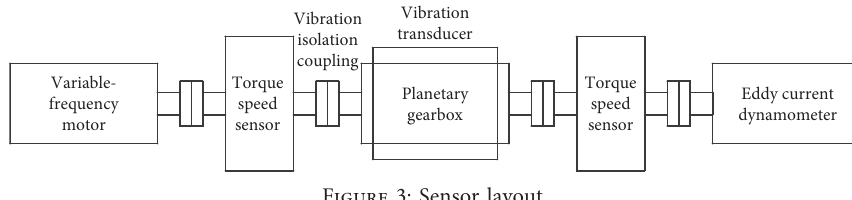
Figure 3: Sensor layout.